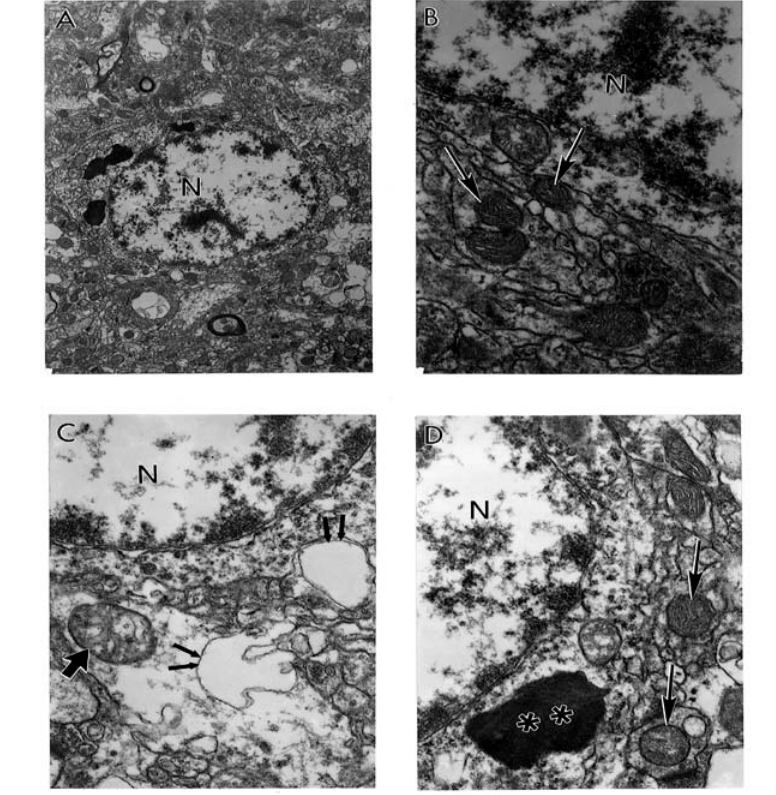
Figure 4. The ultrastructural characteristics of the neuronal mitochondria from AD brain biopsy. A. Neurons with different degrees of ultrastructural lesions. Partially and completely damaged mitochondria are mostly located in the neuronal cell body and coexist with lipofuscin formation. Original magnification X 5,000. B. Large numbers of electron- dense hypoxic mitochondria (indicated by single arrows) were present throughout the cell body and characterized the abnormal mitochondrial cristae. Original magnification: X 20,000. C. Partially (indicated by single arrow) and completely damaged (double arrow) mitochondria. Original magnification X 20,000. D. The neuronal cell body shows the presence of hypoxic mitochondria (indicated by single arrows) close to lipofuscin (double asterisk). Original magnification X 20,000. Abbreviations used in figure: N– neuronal nucleus (reprinted from [87] with